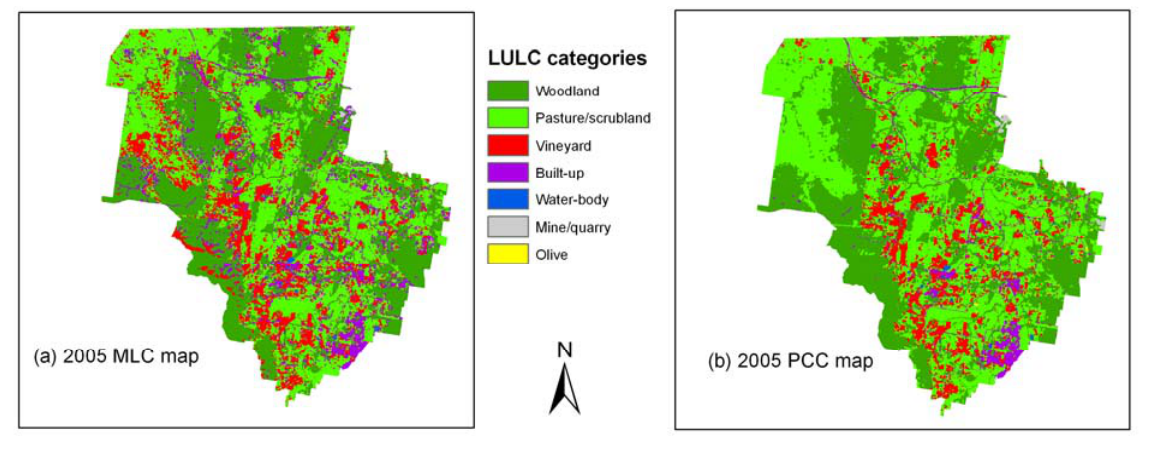
Figure 3. Classified maps: (a) MLC and (b) PCC maps for 2005.